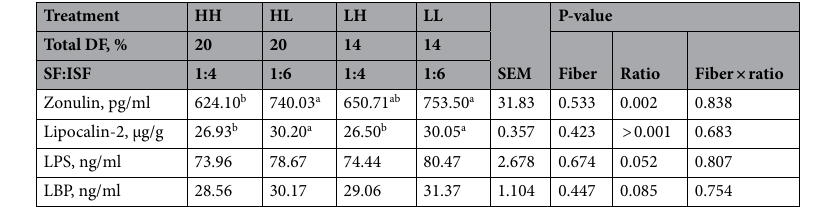
Table 5. Effects of total dietary fiber levels and soluble, insoluble dietary fiber ratio on plasma zonulin, fecal lipocalin, serum LPS and LBP levels of sows. SEM standard error of means, LPS lipopolysaccharides, LBP lipopolysaccharides-binding protein, DF dietary fiber, SF soluble fiber, ISF insoluble fiber. a,b Means with different superscripts within rows are significantly different at (P <